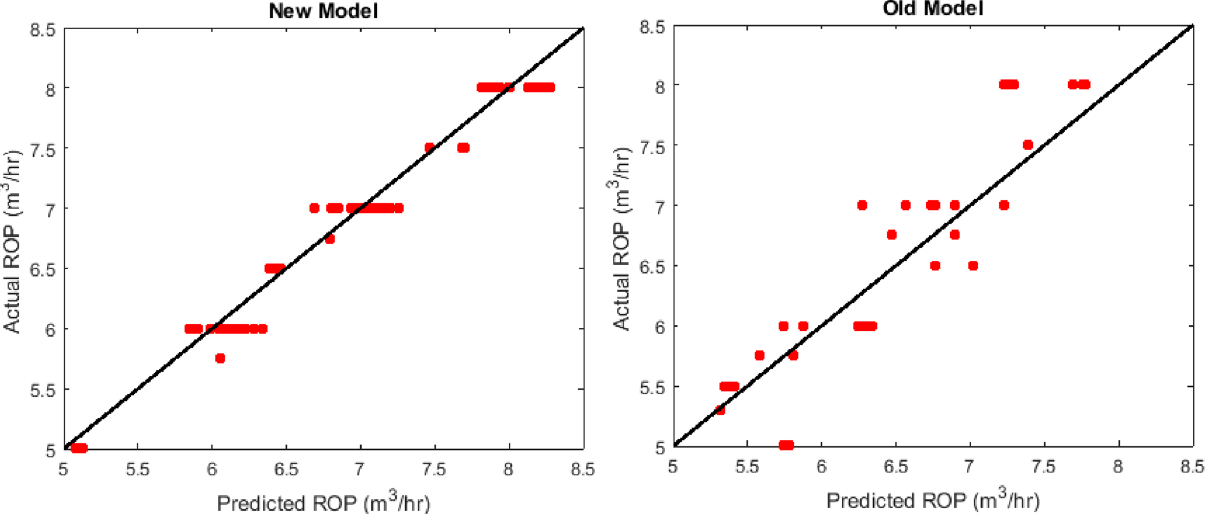
Fig. 36 Predicted versus actual ROP for partial